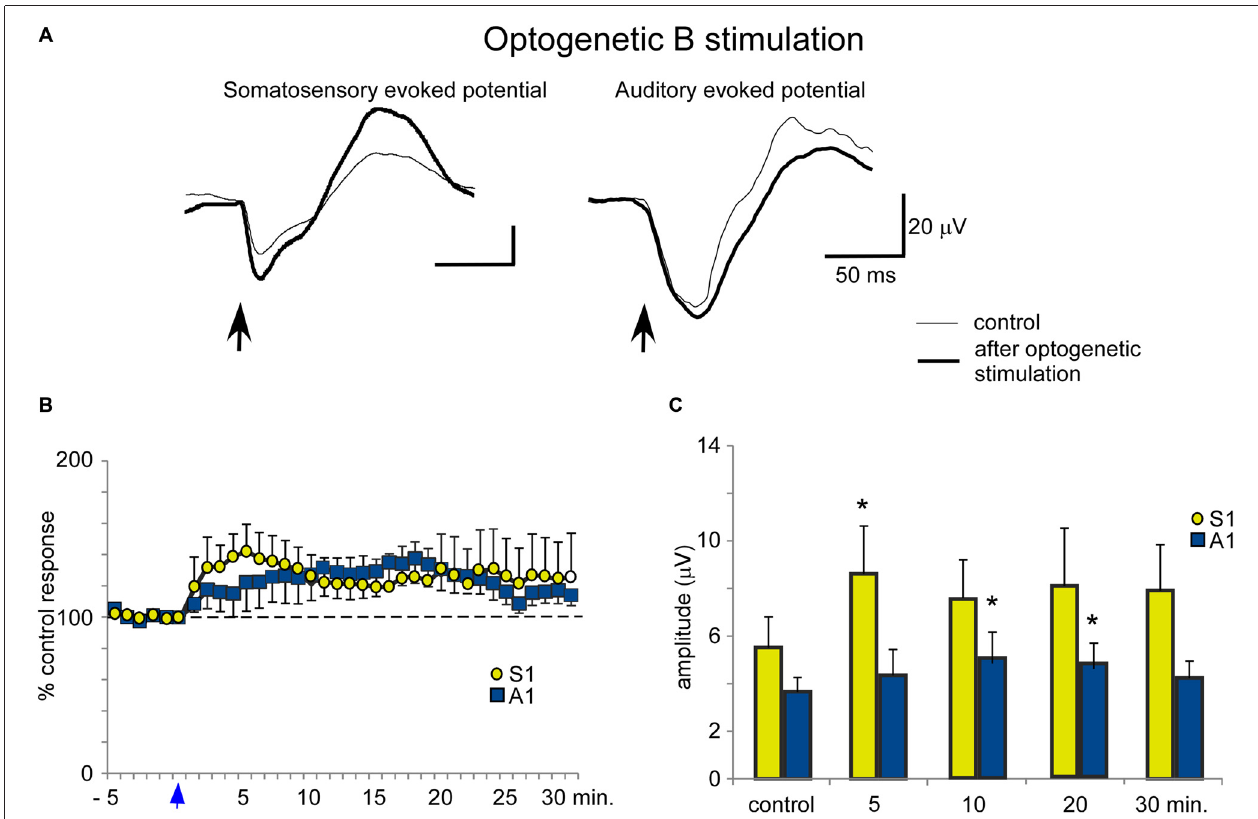
FIGURE 8 | Blue light stimulation of B nucleus induces an increase of somatosensory and auditory evoked potentials. (A) Raw data shows that only somatosensory evoked potentials were affected by blue light stimulation at the B nucleus (control and 5 min after stimulation; thin and thick traces, respectively). (B) Plot shows the time course of evoked potential amplitude in 12 cases (light stimulation occurs at reference 0 s; vertical blue arrow). The 100% represent the mean amplitude during the control period. (C) Plot of the mean amplitude measured in control and 5, 10, 20 or 30 min after blue light stimulation at the B nucleus. The effect was smaller than after HDB